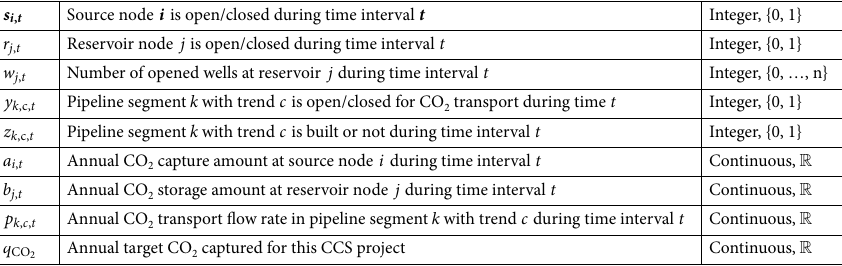
Table 1. Decision parameters in SimCCS 3.0